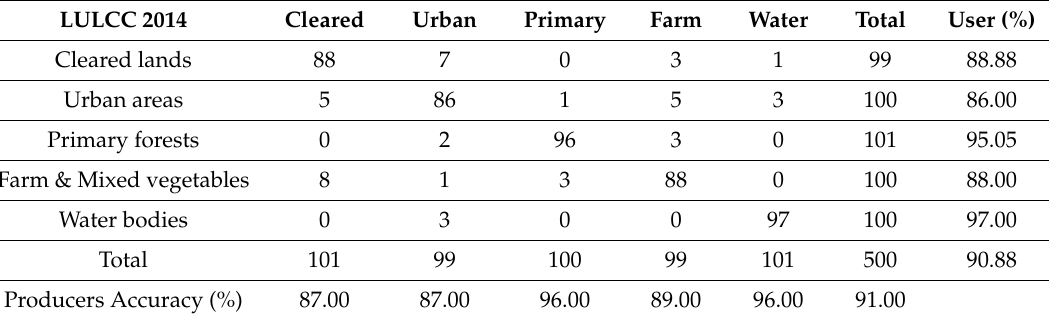
Table 7. Confusion matrix table of 2014 land cover classification.